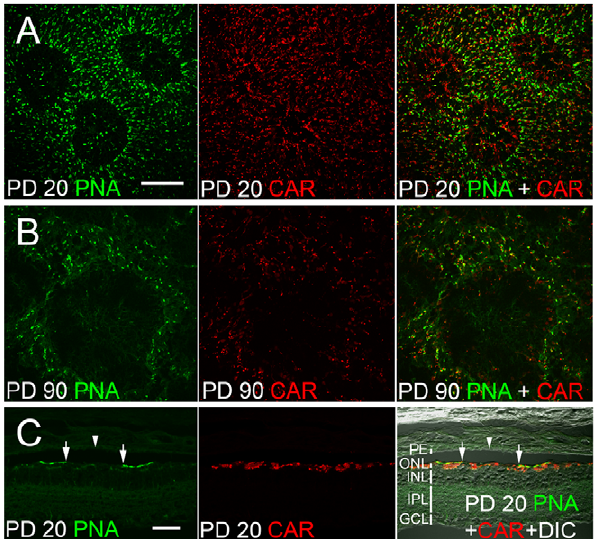
Figure 5. Loss of COS and cone cells. Whole-mounted retinas (superior regions) of S334ter-3 rats were double stained with PNA and antibodies against cone arrestin (CAR). In the retina of PD 20 (A), many CAR positive cells were found in the PNA-negative areas. In the retina of PD 90 (B), however, only a few CAR-positive cells remained in the PNA- negative areas. Cryosections of a PD 20 retina (C) double stained with PNA and antibodies against CAR showed a gap of PNA staining corresponding to a negative area seen in whole-mounted retinas (C, between two arrows). CAR positive cells were found in the gap. The retina detachment (arrowhead) showed that in the PNA-negative area (between two arrows), the corresponding RPE side is also negative. Retinal layers were indicated in C with white vertical bars. PE: RPE; ONL: outer nuclear layer; INL: inner nuclear layer; IPL: inner plexiform layer; GCL, ganglion cell layer. Scale bars: 100 m m for A and B; 50 m m for C.